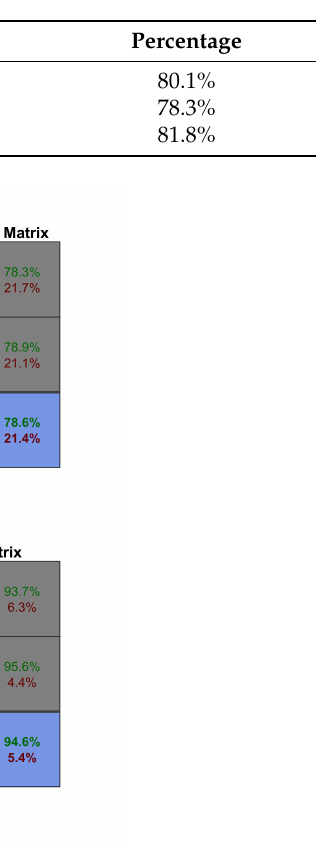
Table 2. Average classification forecasting accuracy.